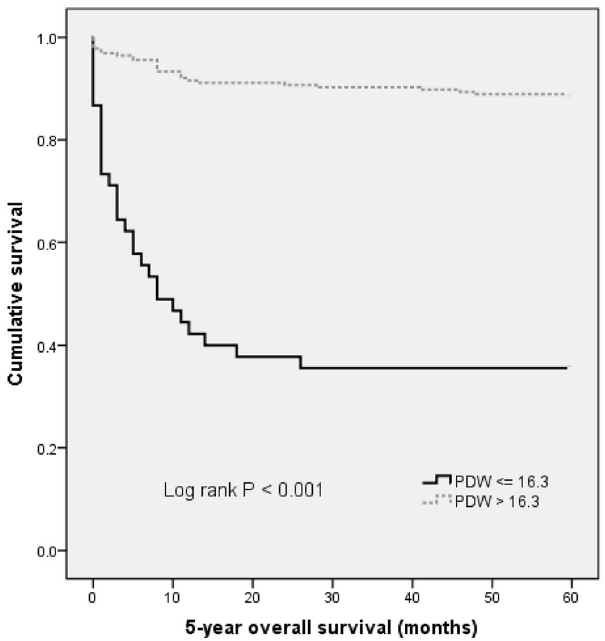
Figure 1. Kaplan–Meier analysis of overall survival in NSCLC